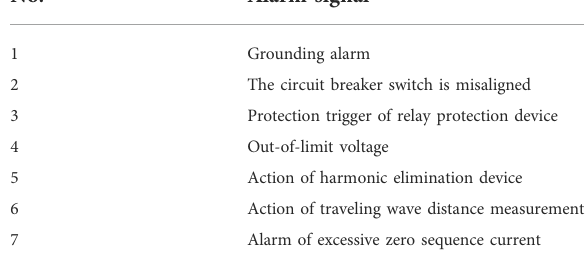
TABLE 1 Related alarm